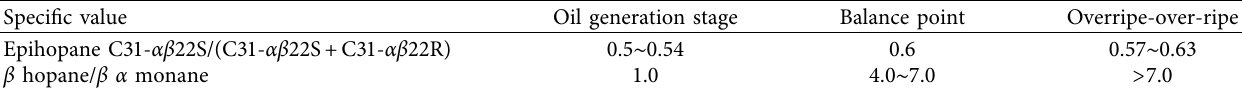
Table 3: Terpene crude oil maturity mark.